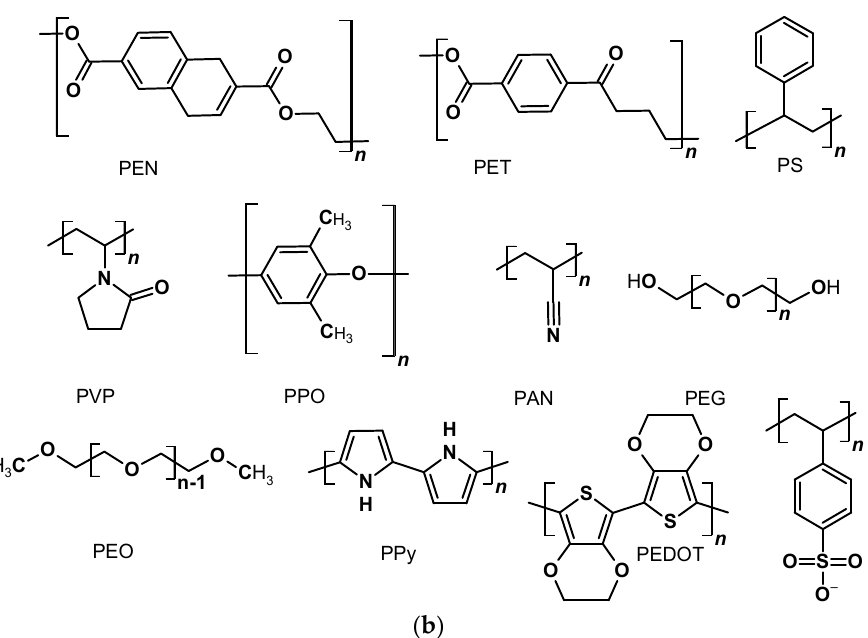
Figure 1. The structures of DSSCs with liquid and solid electrolyte ( a ) and polymer structures often used in this type of solar cell ( b ).